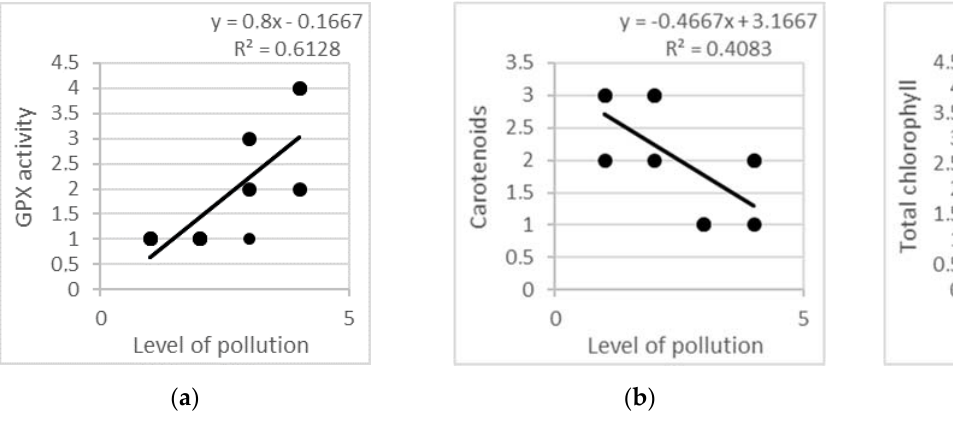
Figure 6. Linear regression models on the basis of all studied leaf samples from three tree species, planted in four urban plots with different types and intensity of anthropogenic impact: ( a ) GPX activity; ( b ) carotenoid content; ( c ) total chlorophyll content.